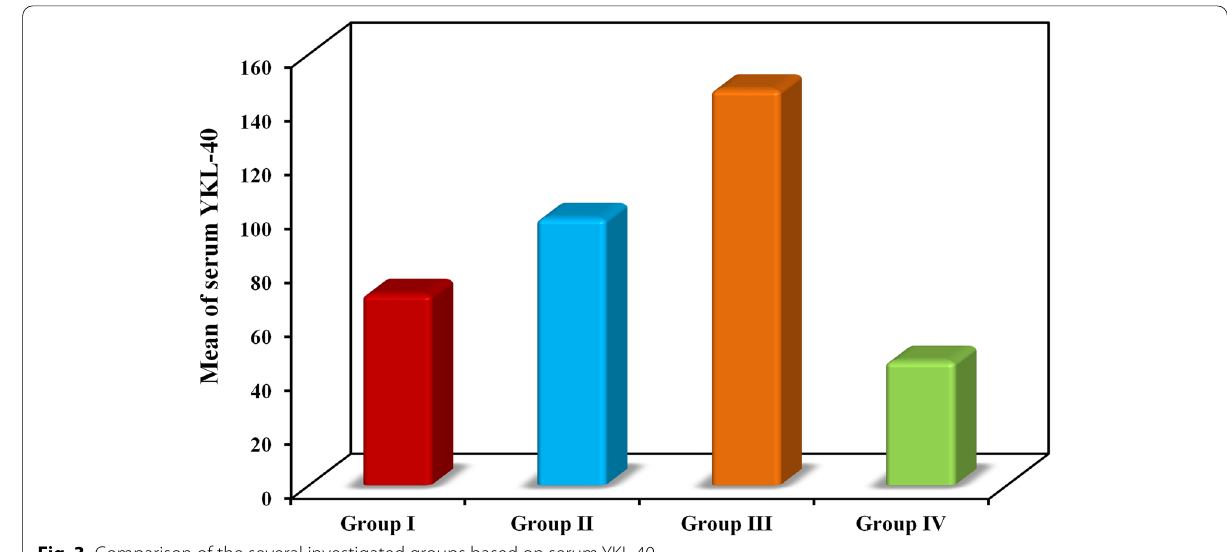
Fig. 3 Comparison of the several investigated groups based on serum YKL‑40